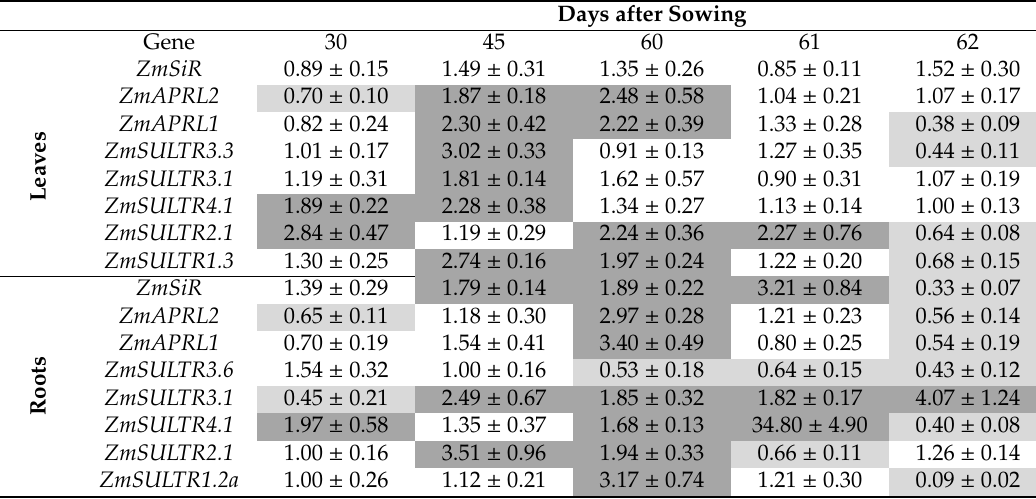
Table 2. Relative expression ratios (the mean of six biological replicates ± SE) of the sulfate transporter and assimilation genes in leaves and roots of mycorrhizal plants. For these calculations, non-mycorrhizal plants were selected as the respective control. Significant di ff erences ( p < 0.05) are depicted with a highlighted table cell. When upregulation of a gene was observed, the respective table cell is dark grey, whilst a light grey cell represents downregulation of the gene. Samplings before sulfur supply: days 30, 45, and 60. Samplings after sulfur supply: days 61 and 62. Days after Sowing Gene 30